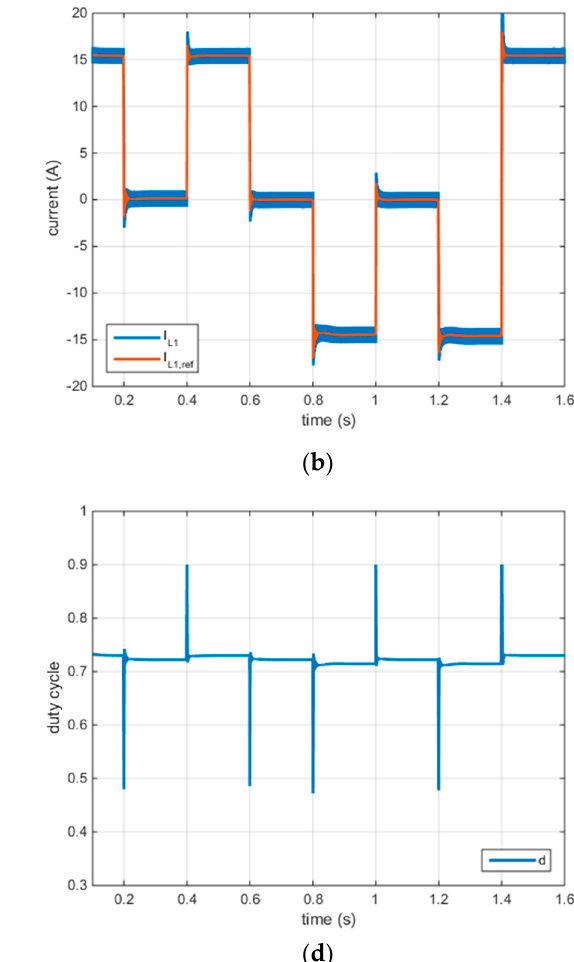
Figure 3. Grid voltage overshoot: ( a ) in baseline scenario; ( b ) in scenario #1 (SS − GN).